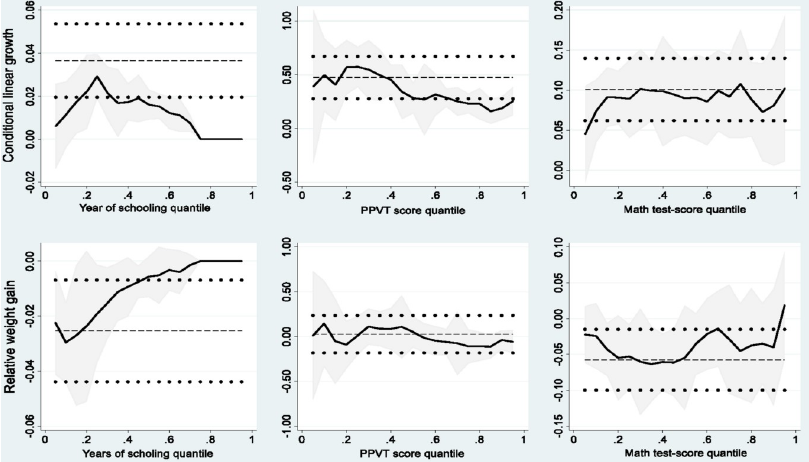
Fig 3. OLS and quantile regressions of CLG and RWG on educational